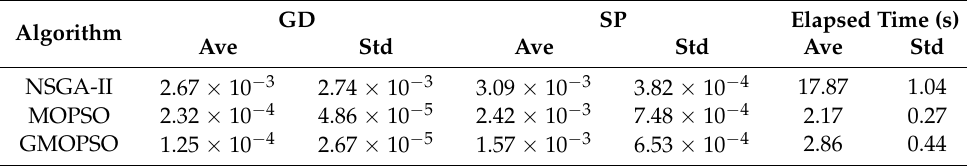
Table 5. Performance comparison for NSGA-II, MOPSO and GMOPSO in test function ZDT3.